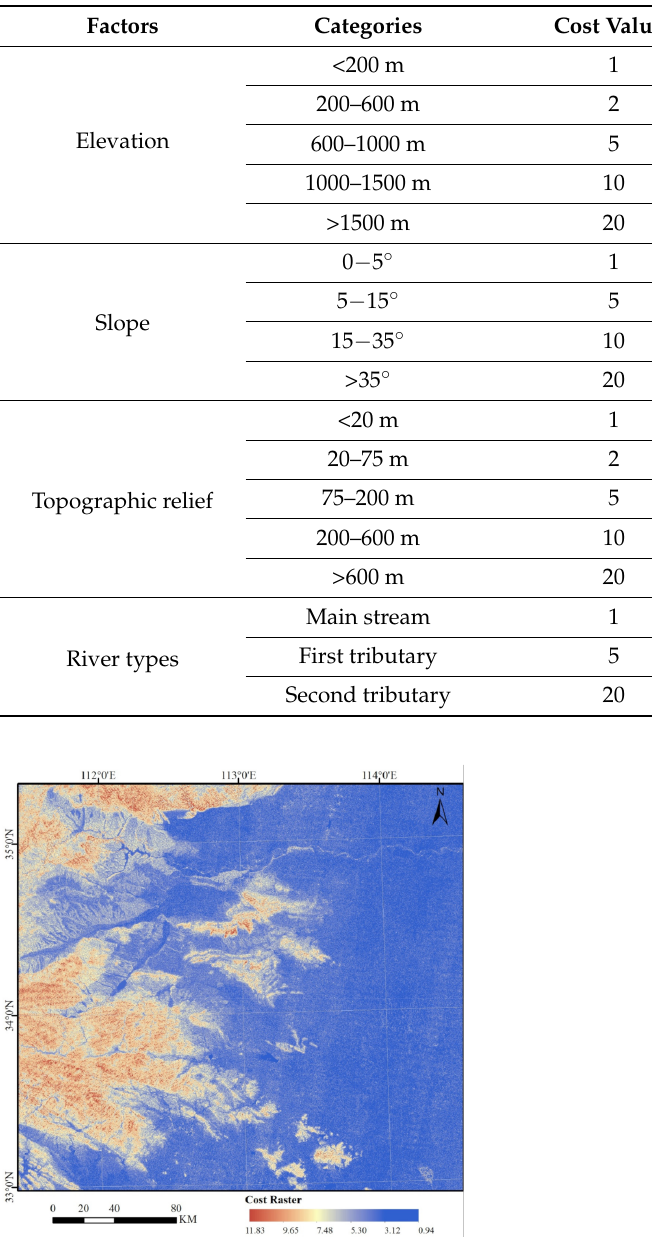
Table 2. Cost values and weights of factors.